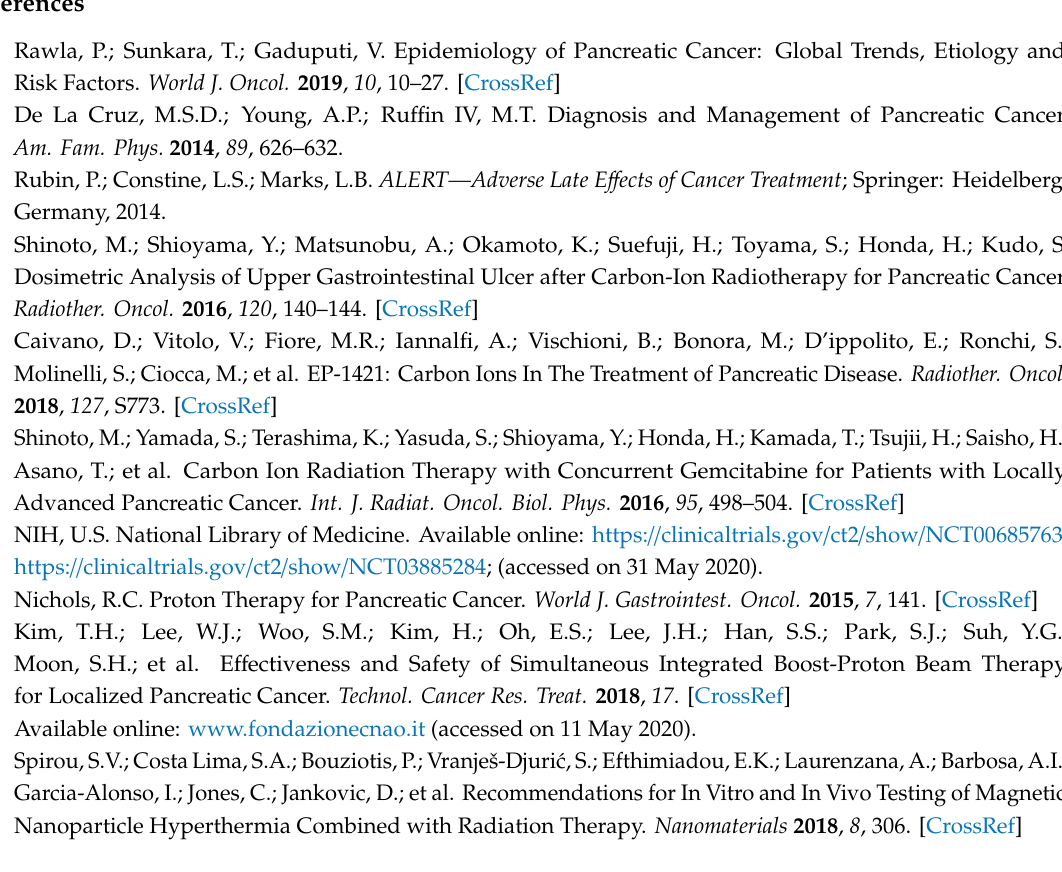
Figure S1: XRD pattern, Figure S2: Zeta potential measurements, Figure S3: SAR estimation method, Tables S1 and S2: determination of optimal time of MNPs uptake and concentration, Table S3: BxPC3 cell cycle analysis after 48 h of treatment with MNPs, Table S4: cellular uptake of MNPs evaluation, Figure S4: dissolution experiments by the radiotracing